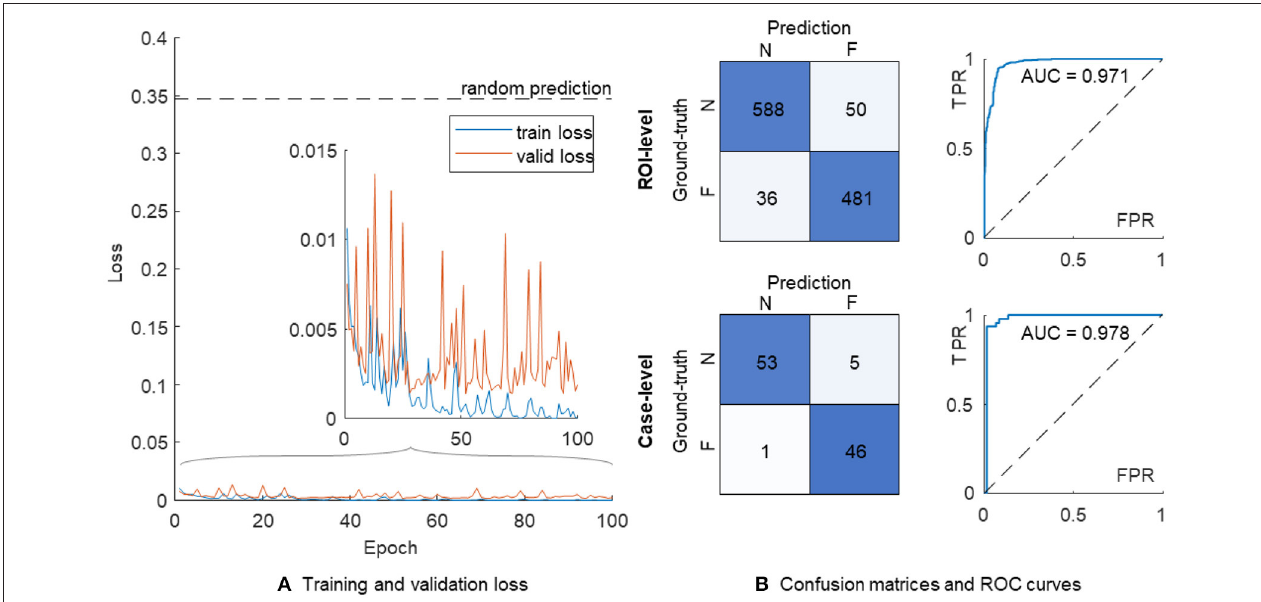
FIGURE 3 | The training process and performance of a single VGG-19 model. (A) Training (in blue) and validation (in orange) losses. (B) The confusion matrices and ROC curves are shown on the ROI-level (top) and case-level (bottom), respectively. N, non-failure; F, failure; ROC, receiver operating characteristic; AUC, area under ROC curve; FPR, false positive rate; TPR, true positive